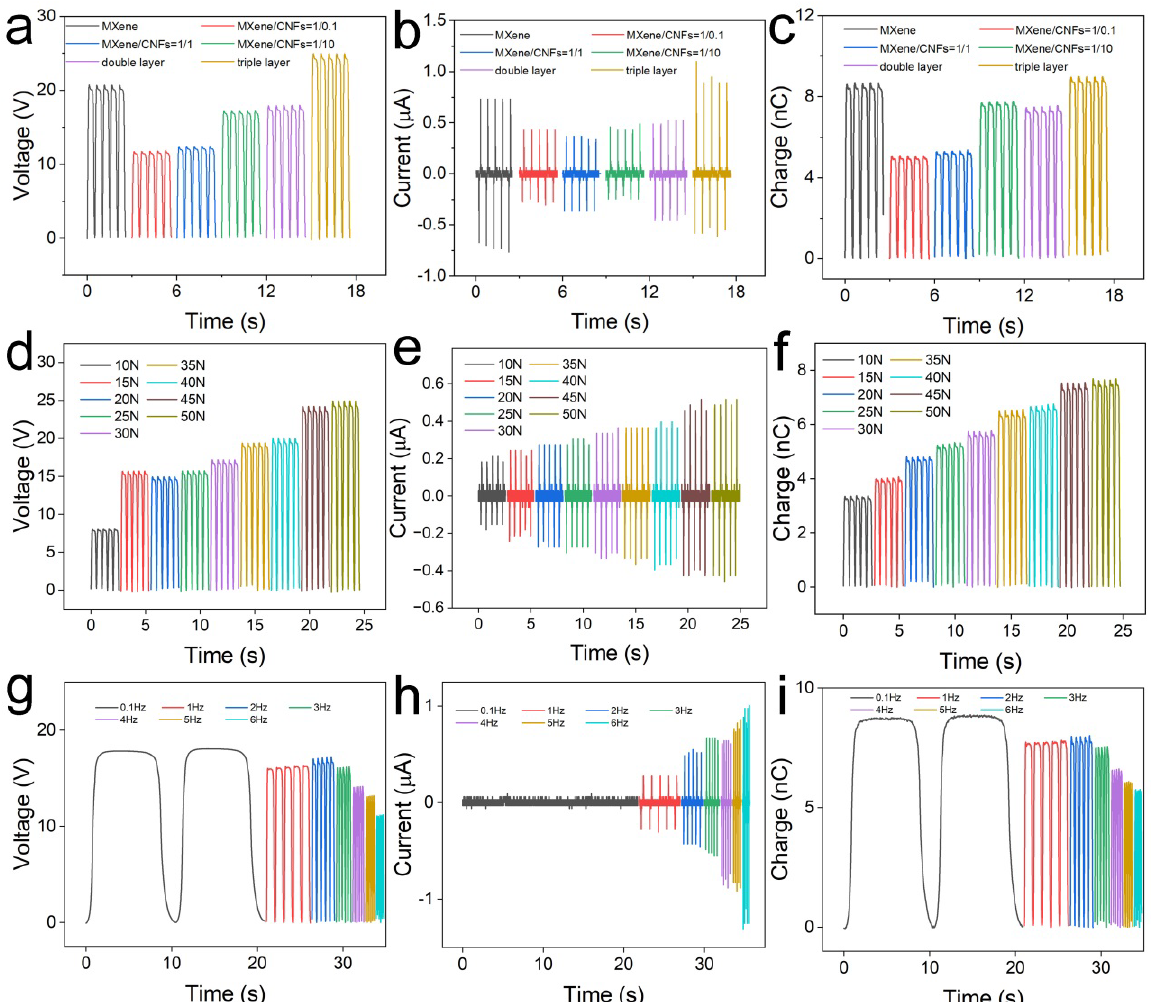
Figure 4. Output electrical performance of TENG. ( a ) Open-circuit voltage, ( b ) output current, and ( c ) transferred charges of TENG based on various bottom electrodes. The relationship between ( d ) open-circuit voltage, ( e ) output current, ( f ) transferred charges of various TENG, and the compressive force. The effect of working frequency on the ( g ) open-circuit voltage, ( h ) output current, and ( i ) transferred charges.